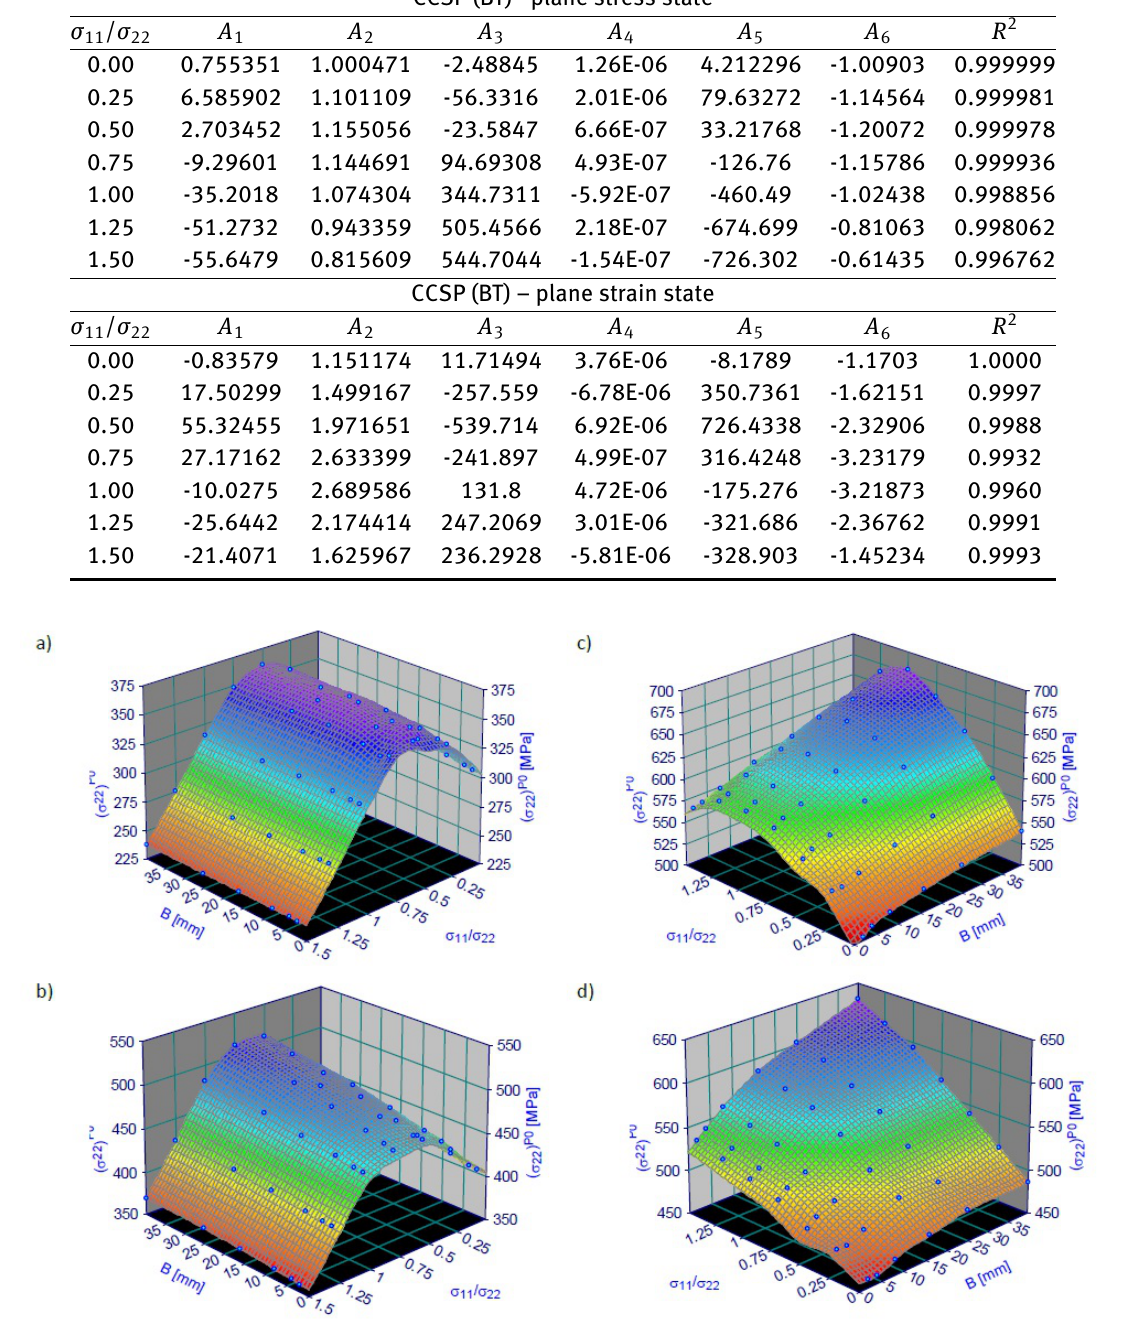
Figure 20: Relationship ( σ 22 ) P 0 = f ( B , σ 11 / σ 22 ) for CCSP(BT), 3D problems – results presented for the fixed relative crack length and yield strength: a) σ 0 = 315, a / W = 0.05; b) σ 0 = 500, a / W = 0.20; c) σ 0 = 1000, a / W = 0.50; d) σ 0 = 1500, a / W =